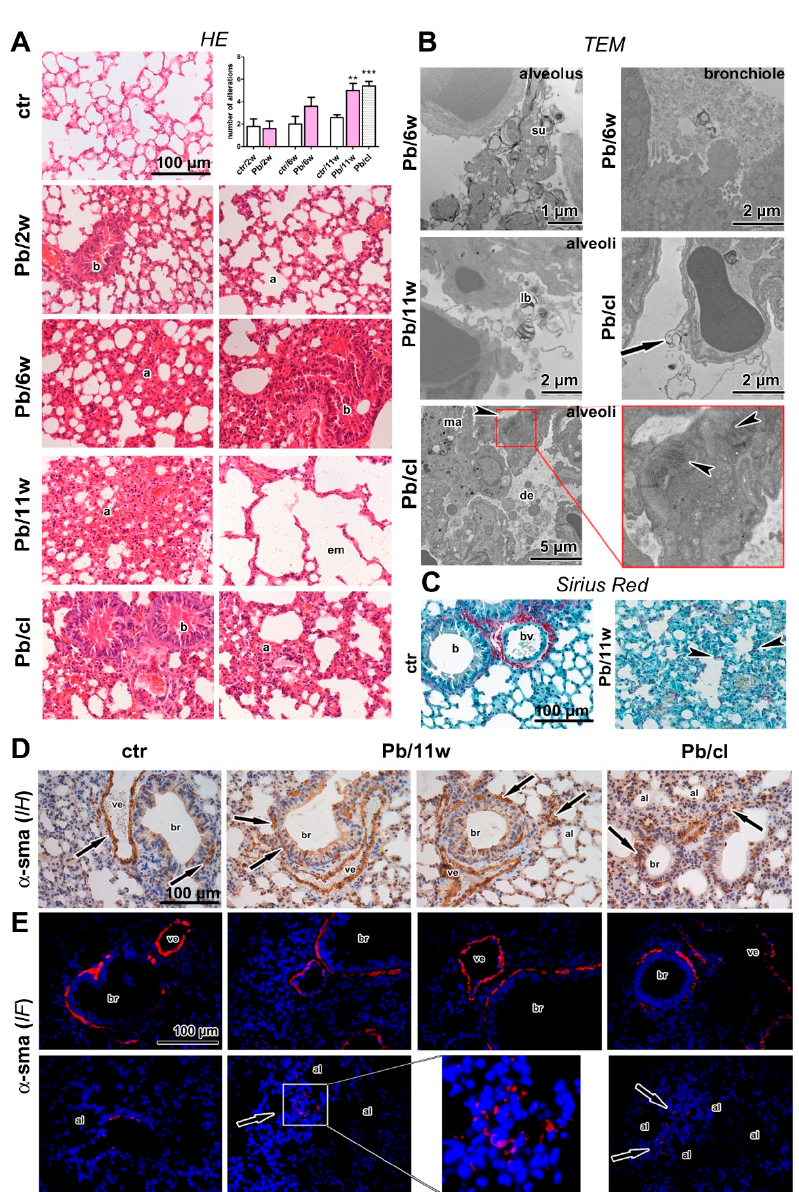
Figure 2. The effect of Pb(NO 3 ) 2 NP inhalation and its clearance on the lungs. ( A ) The lungs in control animals, and after 2-week Pb(NO 3 ) 2 NP inhalation were without serious pathological changes. The lungs after 6 and 11-week Pb(NO 3 ) 2 NP inhalation exhibited remodeling in bronchiolar (b), and alveolar areas (a). The serious damage of lung parenchyma with destroyed alveolar septs and alveolar emphysema detected in some areas (em). Alteration of lung tissue was still detected after a 5-week clearance period. Statistical evaluation of the histopathological changes in both control and Pb(NO 3 ) 2 NP-exposed groups in the experiments delineated in Table S1. The graphs values refer to average ± SD; ** p < 0.01, and *** p < 0.001 compared with the corresponding control group (ctr) by unpaired t -test. ( B ) The expressive lung secretion was found in bronchioles, and alveolar spaces by transmission electron microscopy analysis (TEM). The higher amount of surfactant (su), lamellar bodies (lb), cell detritus (de) and enormous macrophages (ma) were in the alveoli. Arrow points to the damaged membranes of alveolar cell, arrowheads indicate high amount of collagen fibrils in the alveolar